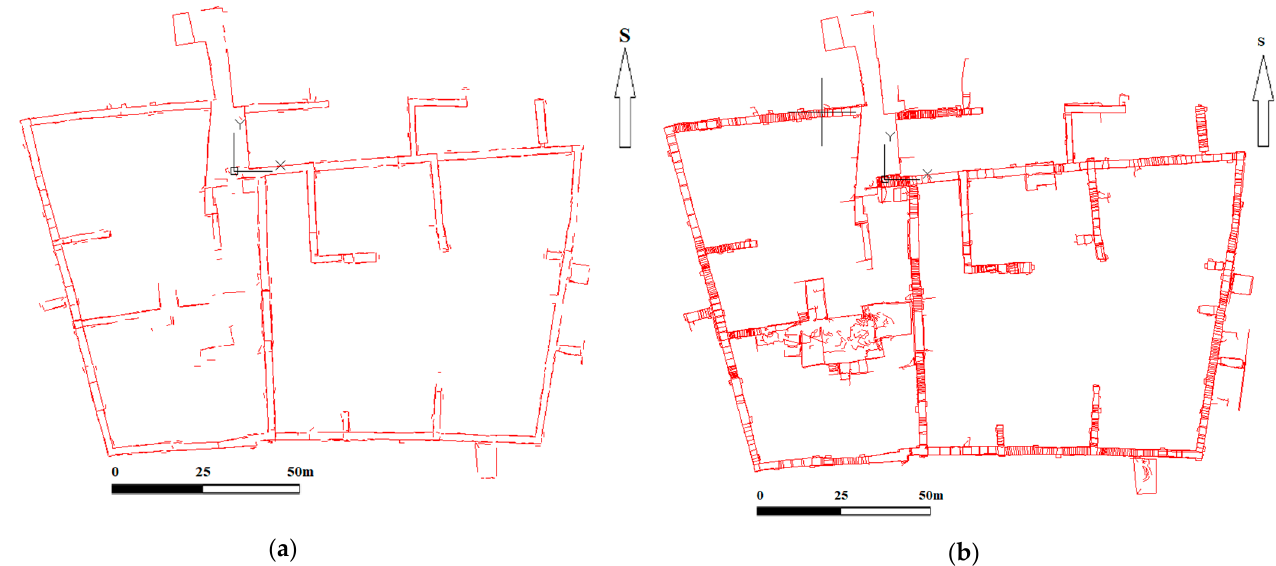
Figure 19. The village of Mansouria. ( a ) An original plan after an automated vectorization from GeoSlam Draw, Mansouria (Zagora); ( b ) an edited vector plan from GeoSlam Draw (approximately four hours of editing of the original automated vectorizing).